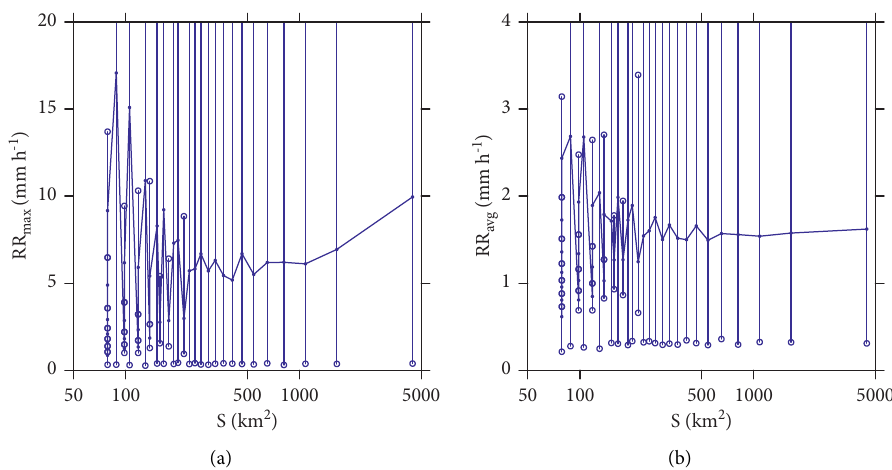
Figure 10: The relationship between RR max and S (a) and RR avg and S (b) on Tibetan Plateau from 1998 to 2015 based on the statistical principle of same samples in each interval at x